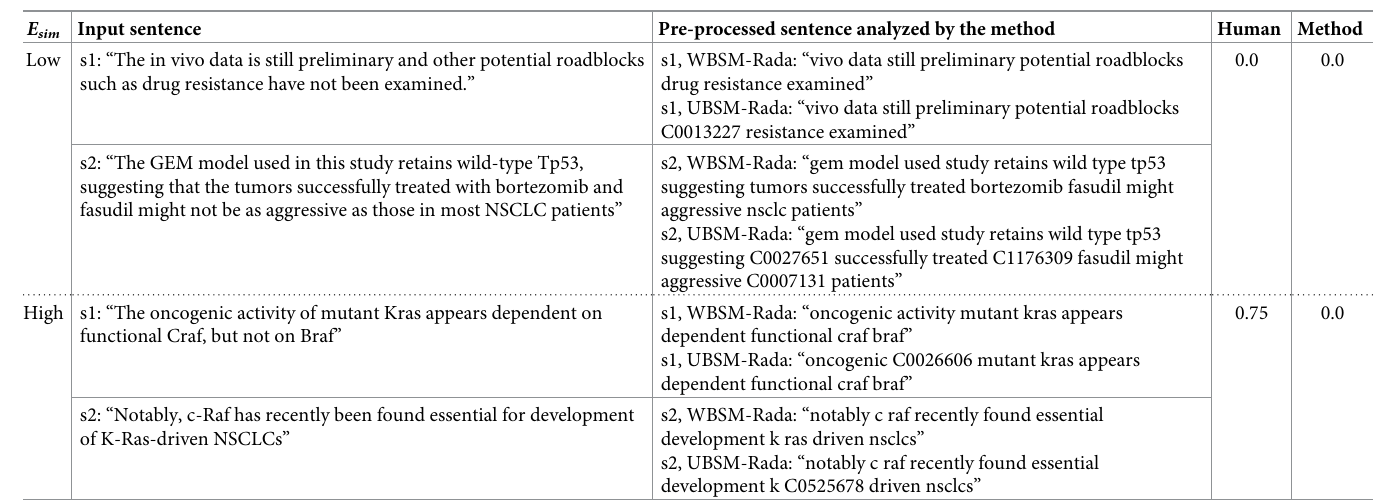
Table 14. Raw and pre-processed sentence pairs obtaining the lowest and highest similarity error E together with their corresponding Normalized human similar- sim ity score (Human) and normalized similarity value (Method) estimated by the COM (M17) method for the raw and pre-processed sentence pairs with the lowest (L) and highest (H) similarity error E . We show the raw and pre-processed sentence pairs evaluated by the WBSM and UBSM similarity methods that make up the COM sim method. The UBSM method use the cTAKES NER tool.